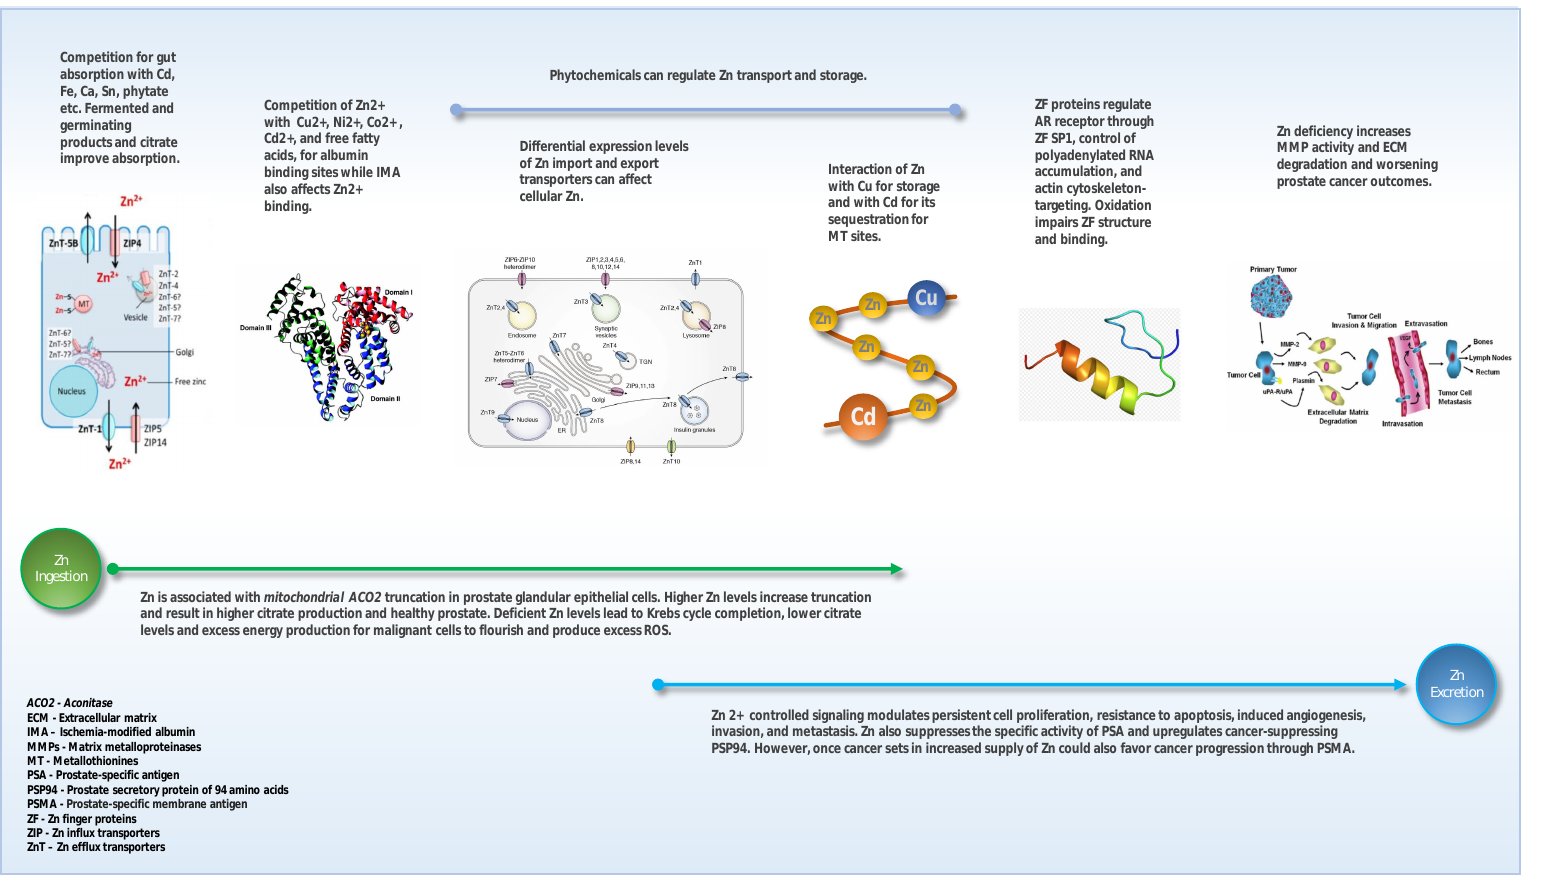
Figure 2. Potential points between Zn ingestion to excretion where Zn absorption, distribution, influx, efflux, and storage may be affected and subsequent impacts on Zn signaling and prostate cancer outcomes. (Images were adapted from Maares and Haase 2022 [20] for Zn gut absorption (under the Creative Commons License 4.0 International (CC BY 4.0), Stewart et al., 2003 [22] for Zn albumin binding (with Copyright (2003) from National Academy of Sciences, U.S.A), Kambe et al., 2021 [57] for Zn transporters under the Creative Commons License 4.0 International (CC BY 4.0), from [206] for ZF SP1 under the Creative Commons Attribution License 3.0 (CC BY 3.0), and Dasgupta et al., 2012 [207] for MMPs-related prostate cancer outcomes under the Creative Commons Attribution License 3.0 (CC BY